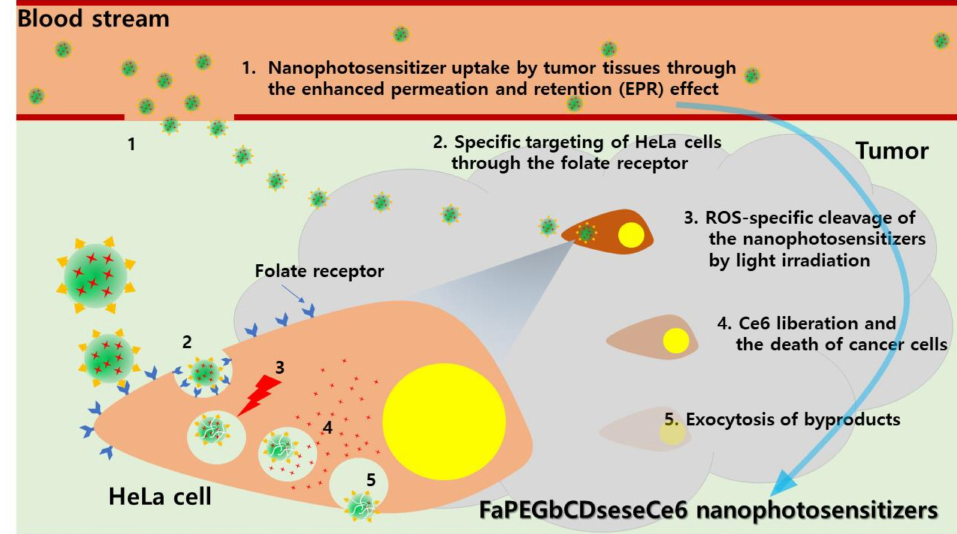
Figure 12. Schematic illustrations of tumor targeting of FaPEGbCDseseCe6 nanophotosensitizers and the mechanism of improved